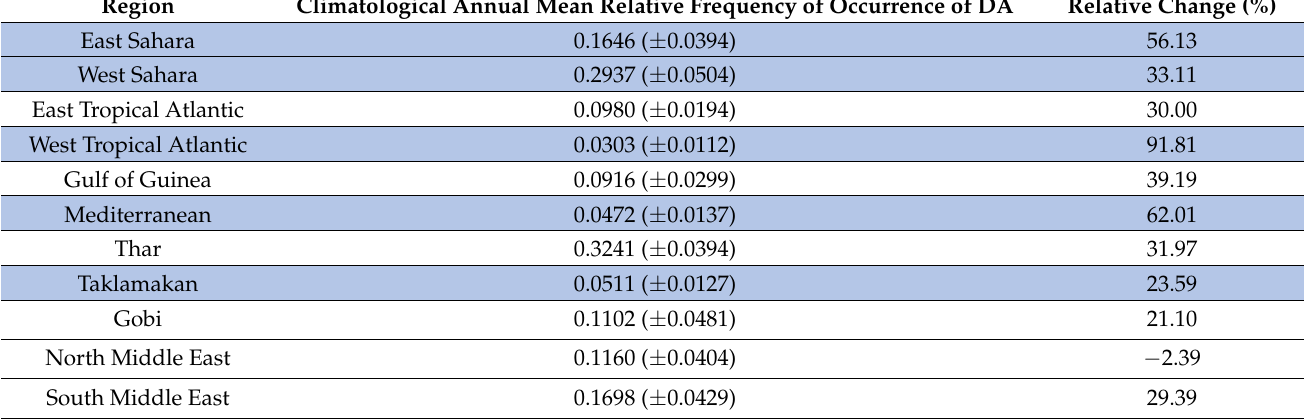
Table 1. Climatological Annual Mean Relative frequency of occurrence of DA, along with the associated standard deviation, and the estimated trend over the 15-year study period (2005–2019). The relative frequency of DA is expressed in terms of the sum of grid cells over which dust aerosols (DA) are observed by the satellite algorithm divided by the total number of grids of the area for which the algorithm operated (see Section 2.2). Blue color indicates the statistically significant trend according to the applied Mann–Kendall